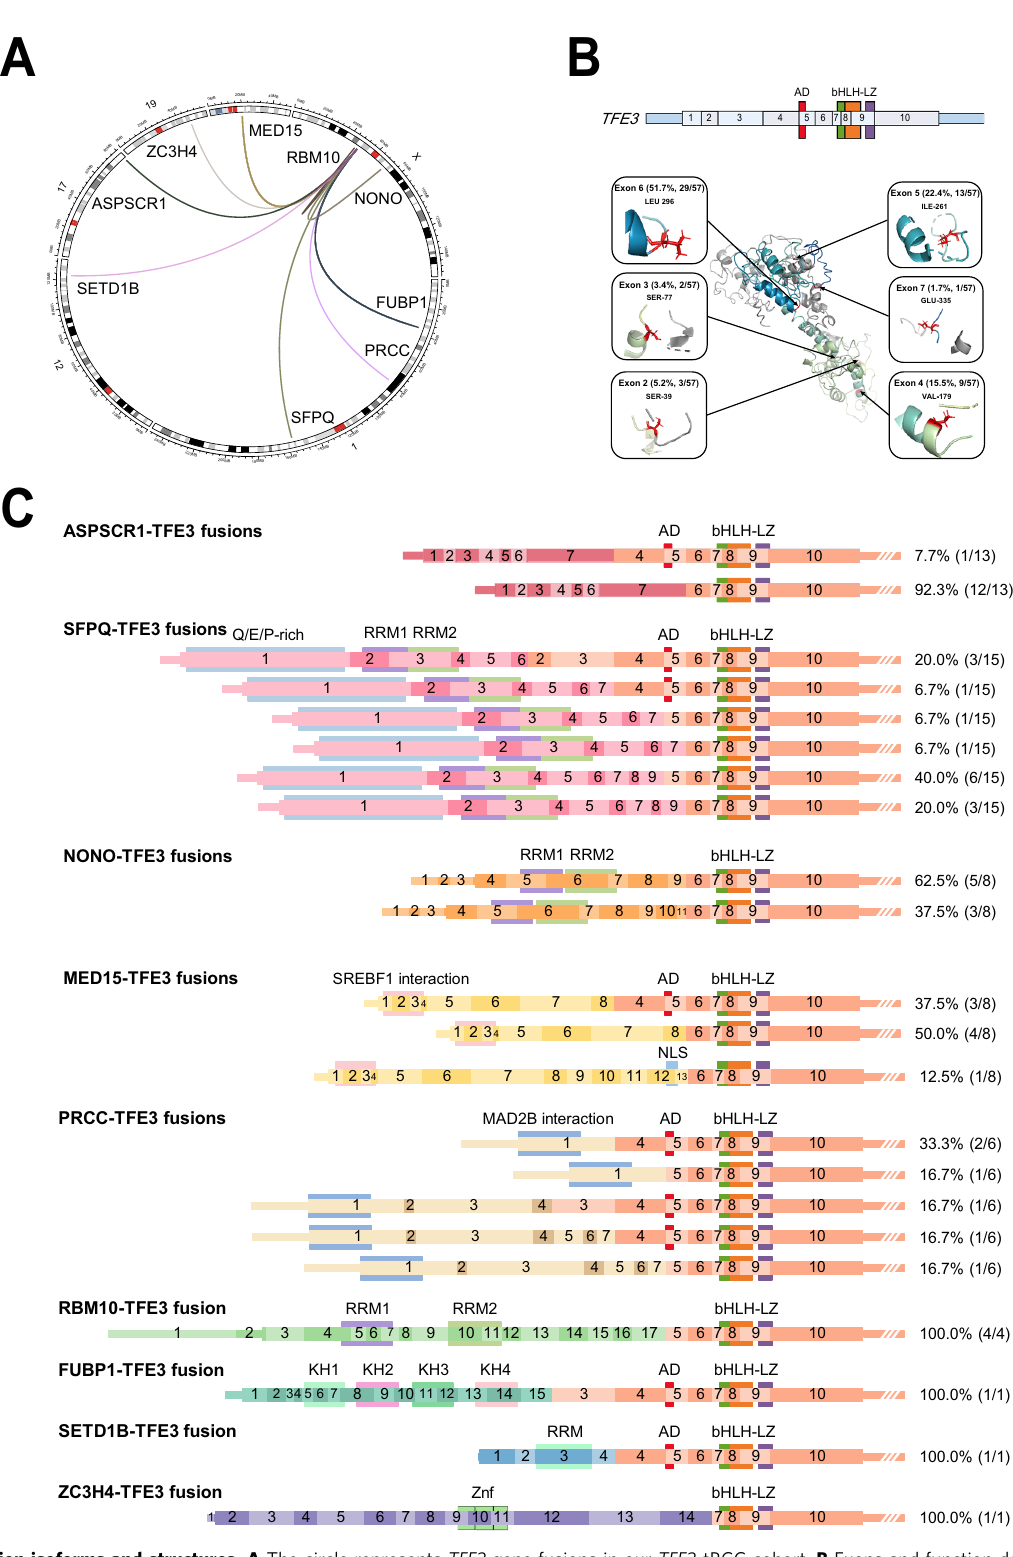
Fig. 1 TFE3 fusion isoforms and structures. A The circle represents TFE3 gene fusions in our TFE3 -tRCC cohort. B Exons and function domains for TFE3 gene (top). Protein domains are color-coded and depicted. Mapping of breakpoints onto the three-dimensional structure of TFE3 protein (bottom). C Exons and functional domains of the TFE3 and fusion partner genes detected in our TFE3 -tRCC cohort. TFE3 -tRCC TFE3 -translocation renal cell carcinoma, AD strong transcription activation domain, bHLH basic helix – loop – helix domain, LZ leucine zipper domain, RRM RNA-recognition motif, SREBF1 Sterol Regulatory Element Binding Transcription Factor 1, MAD2L2 mitotic spindle assembly checkpoint protein MAD2B, KH K homology domain, Znf zinc- fi nger